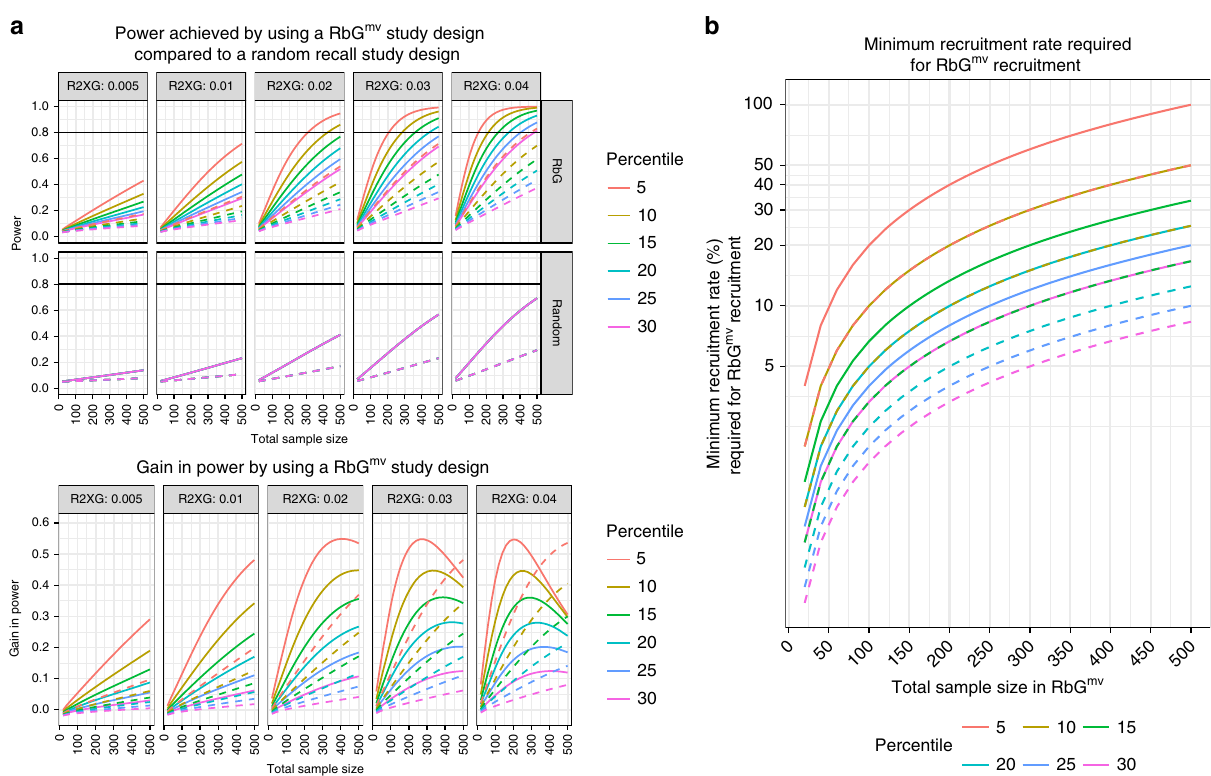
Fig. 4 Comparative power: RbG mv versus random recall study design. a Top panel: A comparison of power ( y -axis) achieved by an RbG mv study design versus a random sample selection design for a given R 2 XG (variance in exposure explained by the genetic risk score (GRS)) and percentile. The x -axis is the total sample size. Lower panel: A representation of the difference ( y -axis) between the power within an RbG mv study design and that from the equivalent random recall experiment. In both the top and bottom panels, solid lines represent the situation where the variance in outcome explained by exposure ( R 2 YX ) is equal to 0.3 and dashed lines represent the situation where R 2 YX is equal to 0.1. b An illustration of the minimum recruitment rate needed in order to recruit suf fi cient study participants for a given RbG mv study sample size ( x -axis) and percentile. Solid lines represent the situation where the size of the genotyped cohort (or biobank) is equal to 5000 people and dashed lines represent the situation where the size of the genotyped cohort (or biobank) is equal to 10,000 people. For details of how the power calculations were carried out, see Supplementary Note 1. Here we use the analytical method and assume a Type I error rate (alpha) of 0.05 and equal-sized genotype groups. The ‘ percentile ’ is the threshold used to recruit from the GRS distribution in the genotyped cohort (or biobank) in the RbG mv study (e.g., percentile 5 corresponds to recruitment from the top and bottom